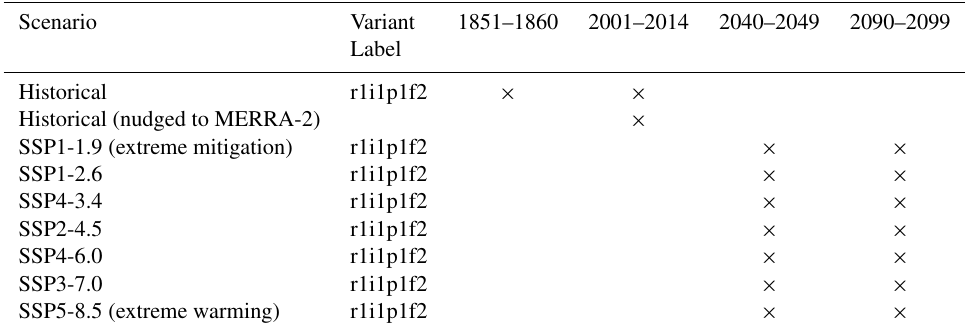
Table 1. GCAP 2.0 meteorology available at the time of publication from the GCAP 2.0 data repository (http://atmos.earth.rochester.edu/ input/gc/ExtData/, last access: 9 September